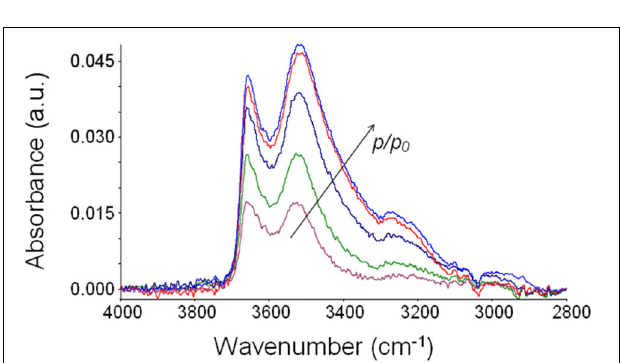
FIGURE 8 | Absorbance spectrum of dry PEEK (blue trace) and of PEI after equilibration with water vapor at 30 ◦ C and p / p 0 = 0 . 7 (red trace). The region of the ν (-OH) band is